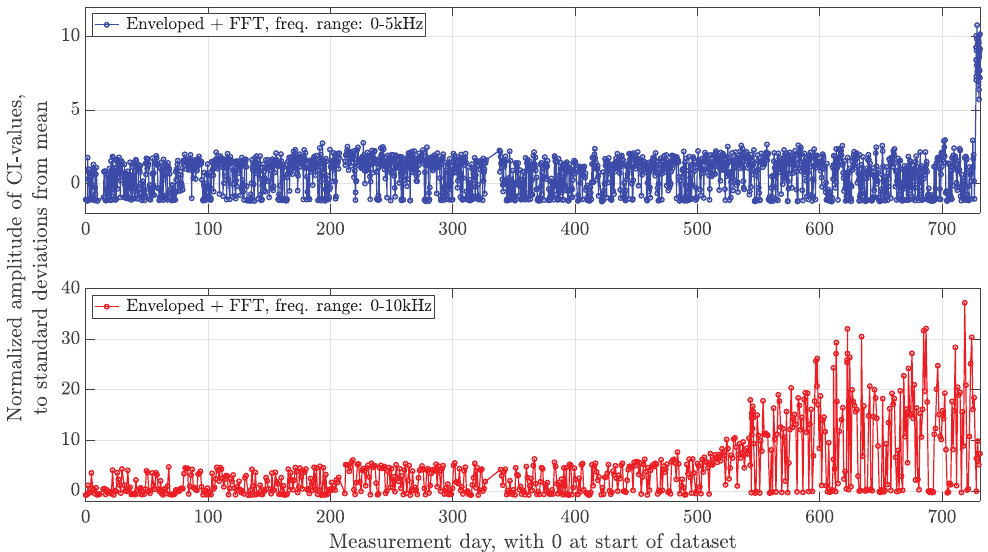
Figure 3. Normalized condition indicator CI-values from FFT spectra on 0–5 kHz and 0–10 kHz frequency range enveloped measurements in blue and red respectively from failure case